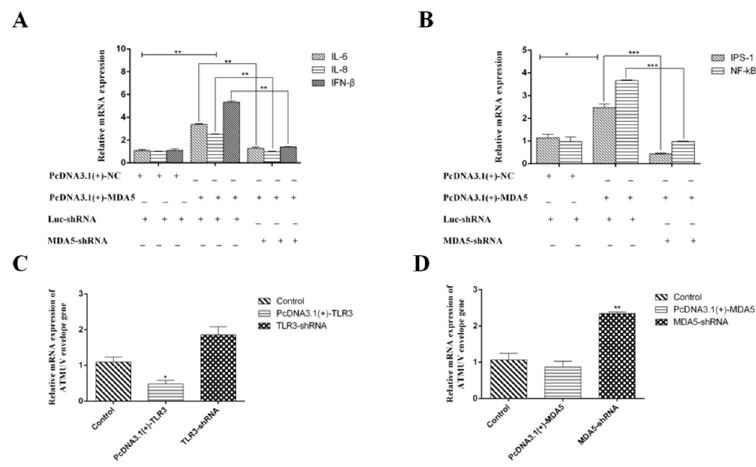
Figure 10. MDA5- and TLR3-dependent signaling pathways play important roles in immunity during DTMUV infection. The expression of IL-6, IL-8, IFN- β , IPS-1 and NF- κ B expression in DEF cells stably expressing shRNA targeting MDA5 and pcDNA3.1( + )-MDA5 were also analyzed by quantitative real-time PCR ( A , B ). ( C , D ) shows the expression of the DTMUV E protein after silencing or over-expressing TLR3 and MDA5 respectively. The average levels from three independent experiments are plotted. In ( A , B ) we transfected pcDNA3.1( + ) -nc and Luc-shRNA as control group, and set them as 1. In ( C , D ) we set control group as 1. The error bars represent the S.E. * P < 0.05, ** P < 0.01.